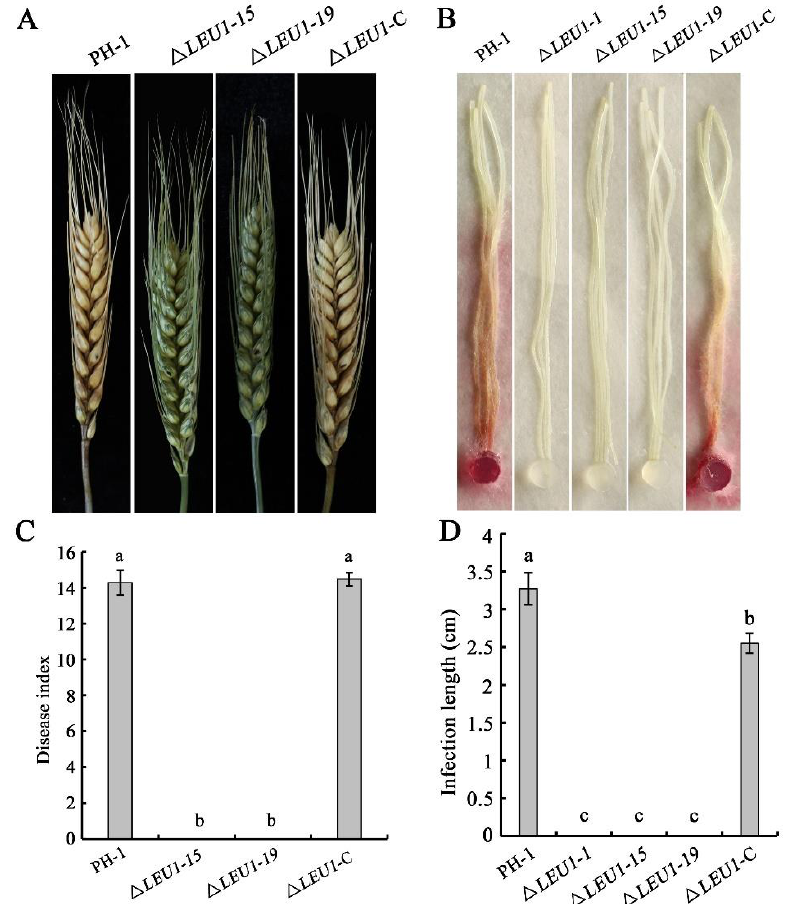
Figure 4. Virulence of the WT strain and FgLEU1 deletion mutants on wheat heads and corn silks. ( A ) Disease symptom on flowering wheat heads caused by PH-1, ∆ LEU1 , and ∆ LEU1 -C strains after injection with conidial suspension (10 µ L, 4 × 10 5 conidia/mL). Images were taken at 14 days post-inoculation (dpi). ( B ) Brown necrosis caused by PH-1, ∆ LEU1 , and ∆ LEU1 -C strain mycelial plugs on corn silks. Images were taken at 5 dpi at 25 ◦ C. ( C ) Disease indices of F. graminearum determined at 14 dpi. At least 20 wheat heads were examined in each replicate. Error bars represent the standard errors of the means. Different letters on the bars for each treatment indicate significant differences at p < 0.05 by Duncan’s multiple range test. ( D ) The length of brown necrotic tissue upon infection was determined at 5 dpi. At least 20 corn silks were examined in each replicate. Different letters on the bars for each treatment indicate significant differences at p < 0.05 by Duncan’s multiple range test.